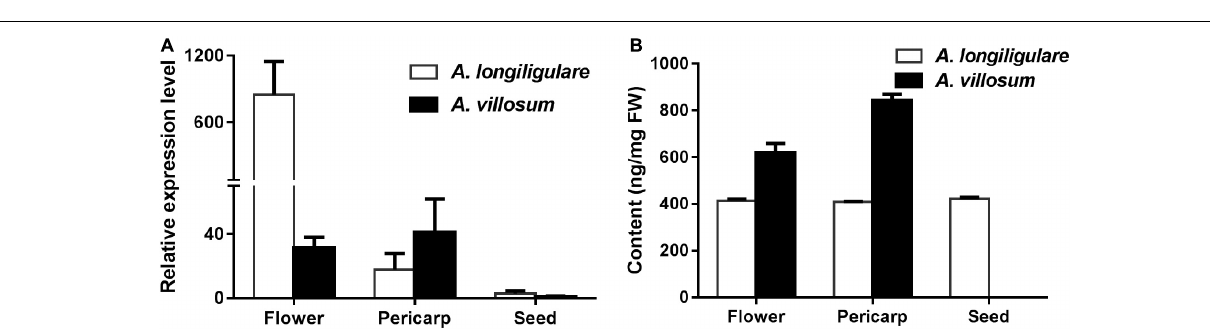
FIGURE 4 | Expression levels of AlTPS2 and AvTPS2 and content of linalool in different tissues of A. longiligulare and A. villosum . (A) The expression levels of AlTPS2 and AvTPS2. (B) Content of